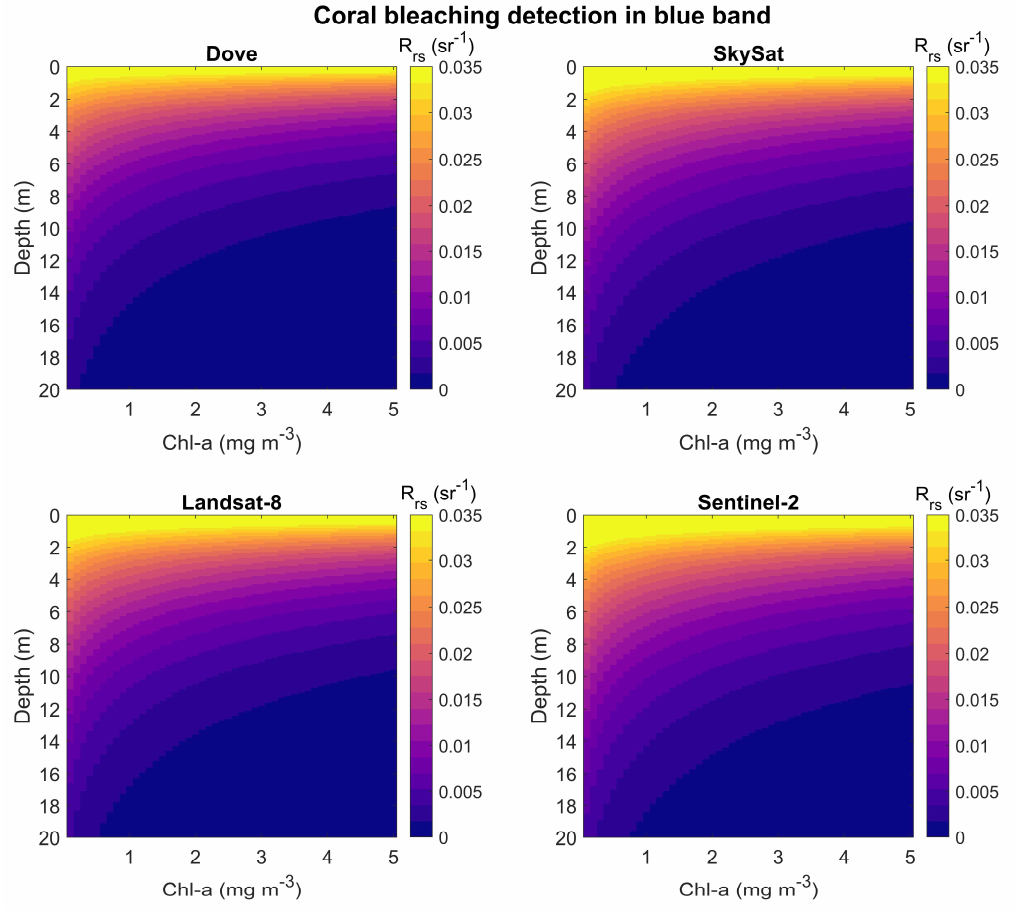
Figure 4. Differences in remote sensing reflectance between bleached and live coral in the blue spectral bands of four different satellite sensors.